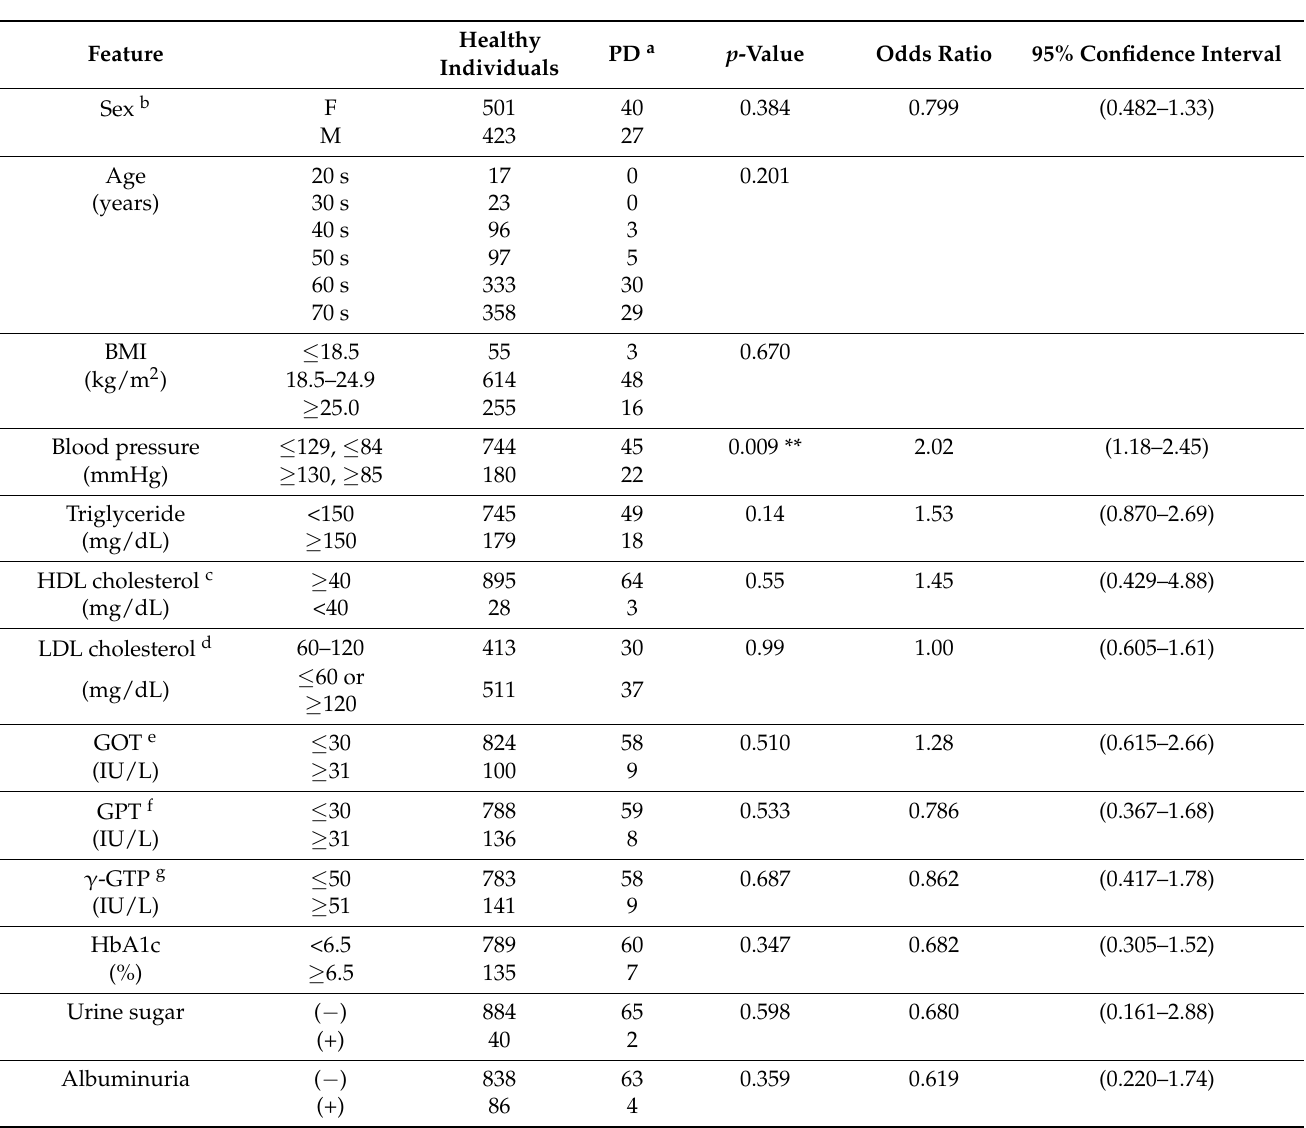
Table 1. Participant